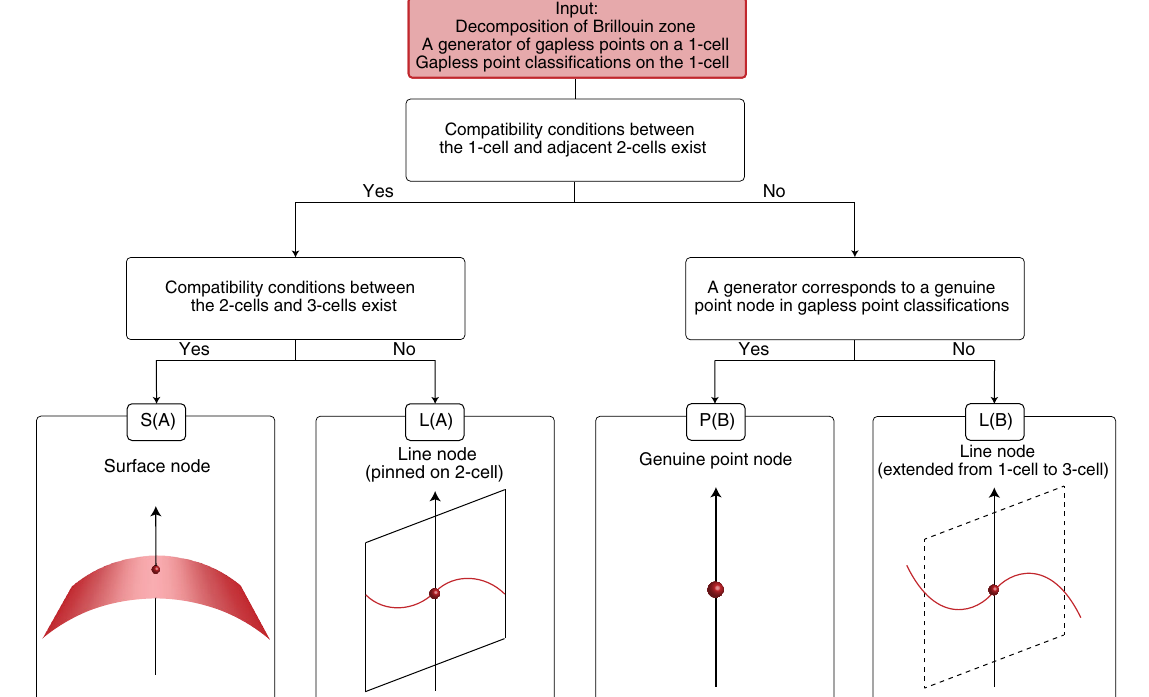
FIG. 4. A flowchart of our classification scheme. In the classification process, we focus on a generator of gapless points on a line (called 1-cell). Here, generator denotes a gapless point caused by a change of zero-dimensional topological invariants for irreducible representations. Such gapless points on the line cannot be split because of symmetry constraints. We separately perform gapless point classifications on the 1-cell. First, we ask if compatibility conditions between the line and adjacent polygons exist or not. If yes, we examine whether compatibility conditions are between the polygons and their three-dimensional neighborhoods. If they exist, the gapless point is part of a surface node, denoted by S(A). Otherwise, the gapless point is part of a line node pinned on the polygons, denoted by L(A). Next, we consider the case where the compatibility conditions between the line and adjacent polygons do not exist. In such a case, we ask if the generator coincides with a genuine point node from the results of gapless point classifications on 1-cells. When the gapless point belongs to case (a) of the gapless point classification, it is a genuine point node, denoted by P(B). If the gapless point is not consistent with the existence of a genuine point node, i.e., the gapless point classification result is case (b) or (c), we conclude that the gapless point is part of a line node, denoted by